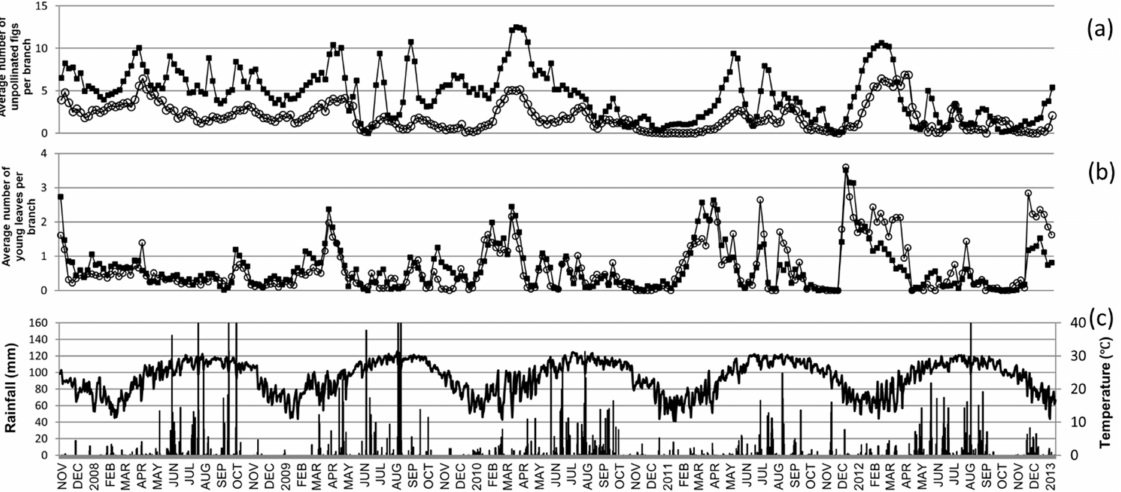
Figure 1. Reproductive and vegetative production in relation to the meteorological factors. Unpol- linated (A-phase) figs ( a ); young leaves ( b ); and daily rainfall and average temperature during the survey period ( c ). The filled squares represent male production and the hollow circles represent female production ( a , b ). The black columns represent rainfall and the black line represents average daily temperature ( c